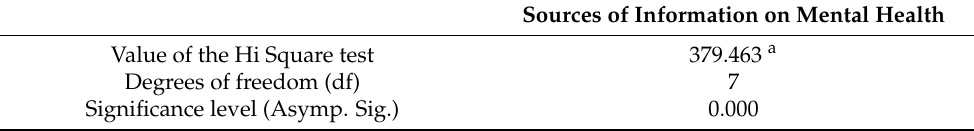
337 337 Table 2. Chi-Square test for testing hypothesis 6. Table 2. Chi-Square test for testing hypothesis 6. Sources of Information on Mental Health Sources of Information on Mental Health Value of the Hi Square test 379.463 a Value of the Hi Square test 379.463 a Degrees of freedom (df) 7 Degrees of freedom (df) 7 Significance level (Asymp. Sig.) 0.000 Significance level (Asymp. Sig.)